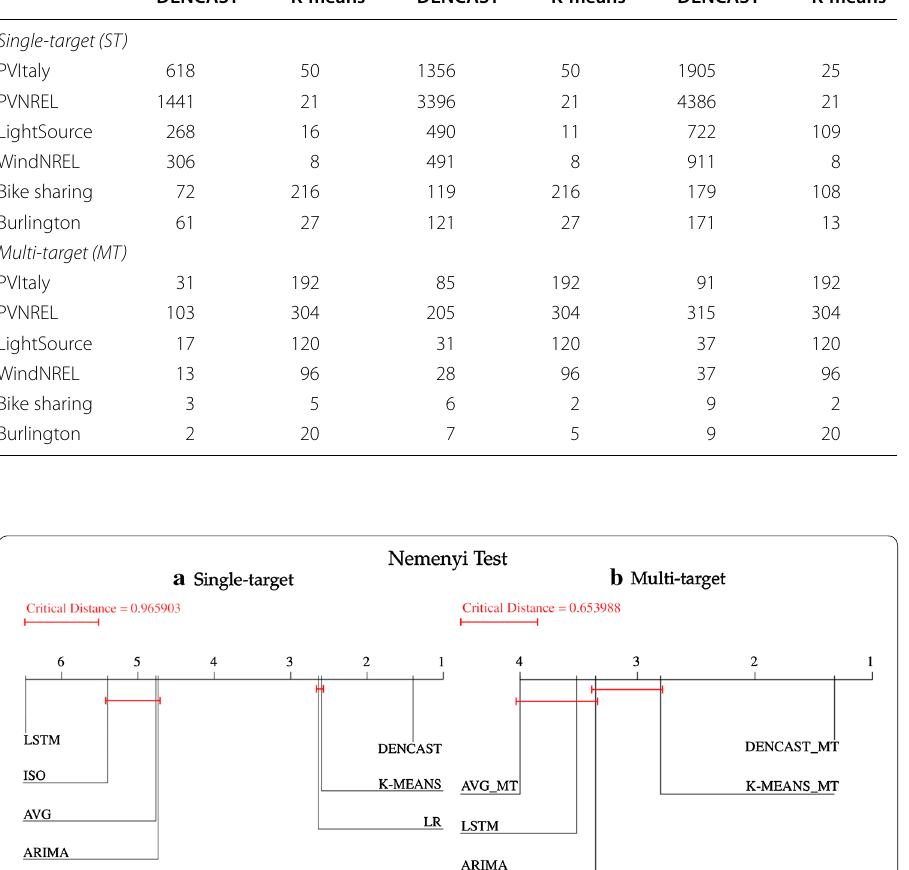
Fig. 5 Nemenyi test for a single-target and b multi-target settings. If the distance between methods is less than the critical distance (at p -value 0.05), there is no statistically significant difference between =